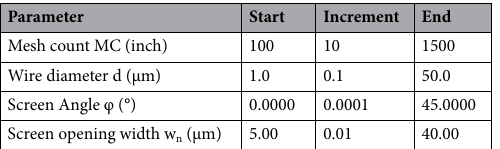
Table 1. Variation of parameters for the simulation of the area of individual opened areas across a screen opening. The length of all simulated channels was set to the industry standard of 156 mm (2020) 3 . The position on the screen orthogonal to the screen opening is averaged over 100 screen